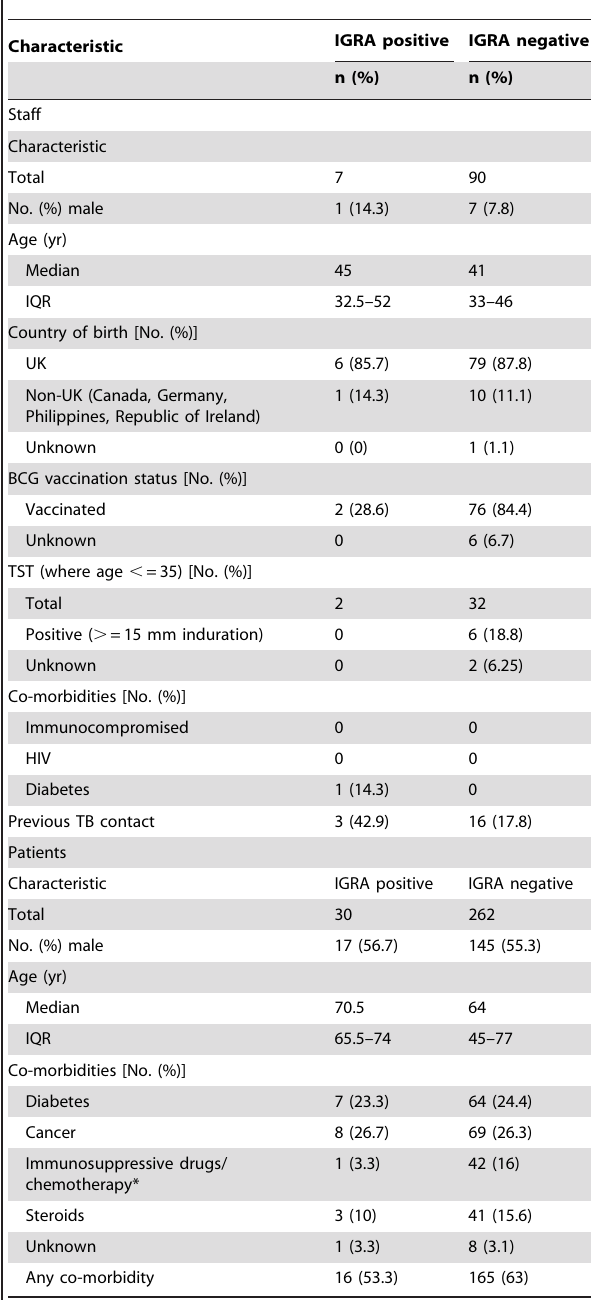
Table 1. Demographic and clinical characteristics of staff (n=98) and patients (n= 333).